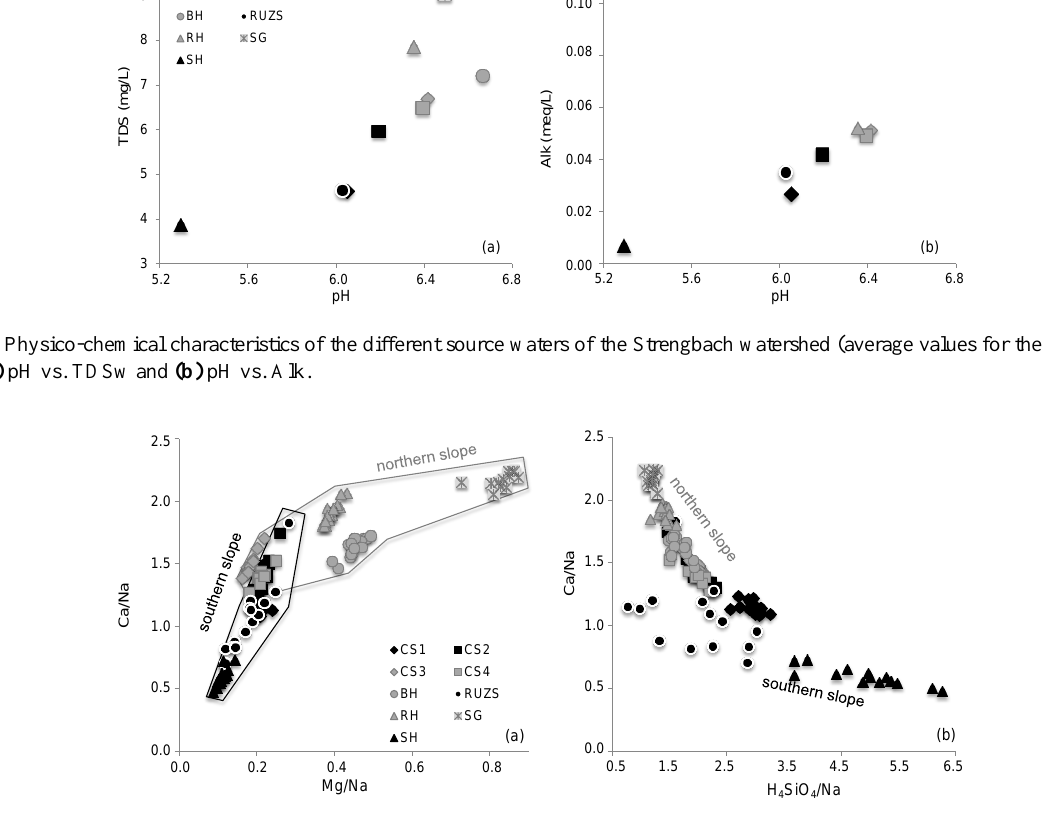
Figure 3. Major element concentration ratios of the 9 different individual source waters of the Strengbach watershed. (a) Ca / Na vs. Mg / Na and (b) Ca / Na vs. Si(OH) 4 / Ca. In each diagram the spring waters from the southern slope show different compositions than those from the northern